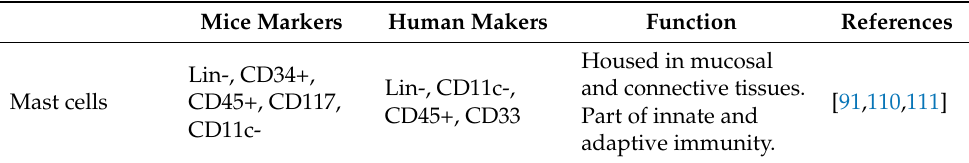
Table 6. Mast cells and